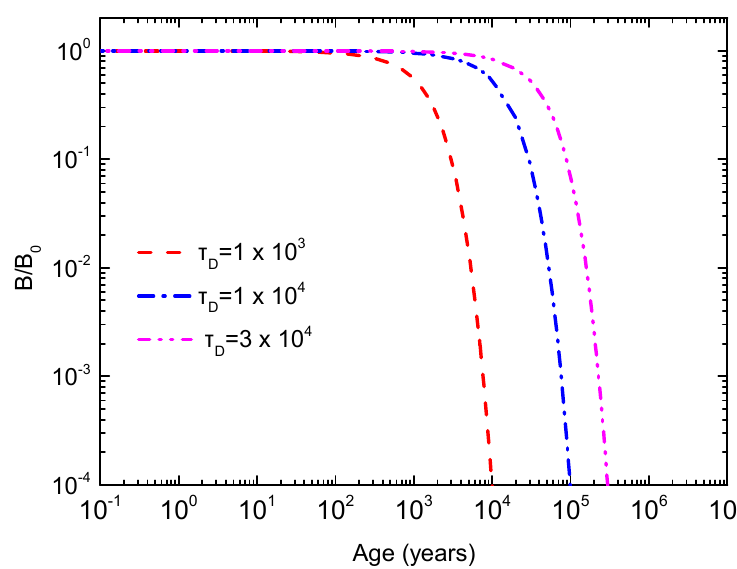
Figure 4. Different magnetic field evolution functions used to represent a neutron star undergoing magnetic field decay. τ D represents the magnetic field relaxation time.